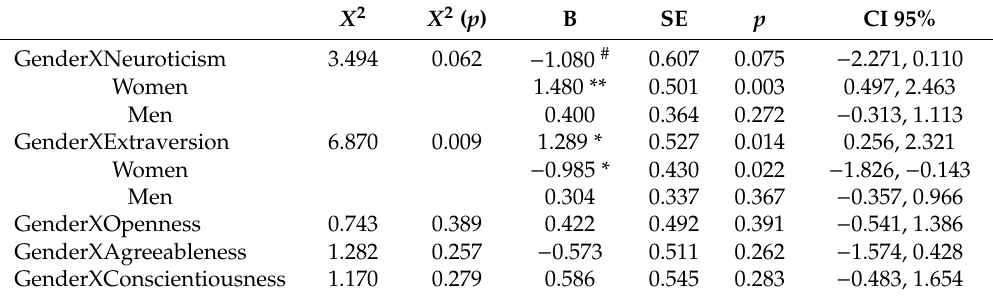
Table 3. Gender moderations in the relationship between personality traits and MetS.